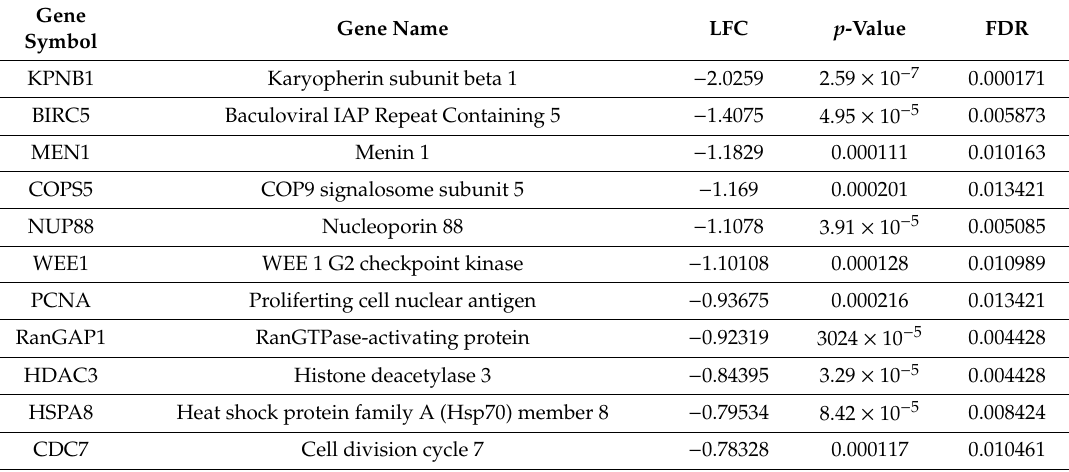
Table 1. XPO1 cargo proteins. XPO1 binding proteins were mined from literature and using NESdb. All cargo proteins that demonstrated statistical significance ( p < 0.01 and FDR < 0.25) are listed with their log-fold-change (LFC), p -value, and false discovery rate